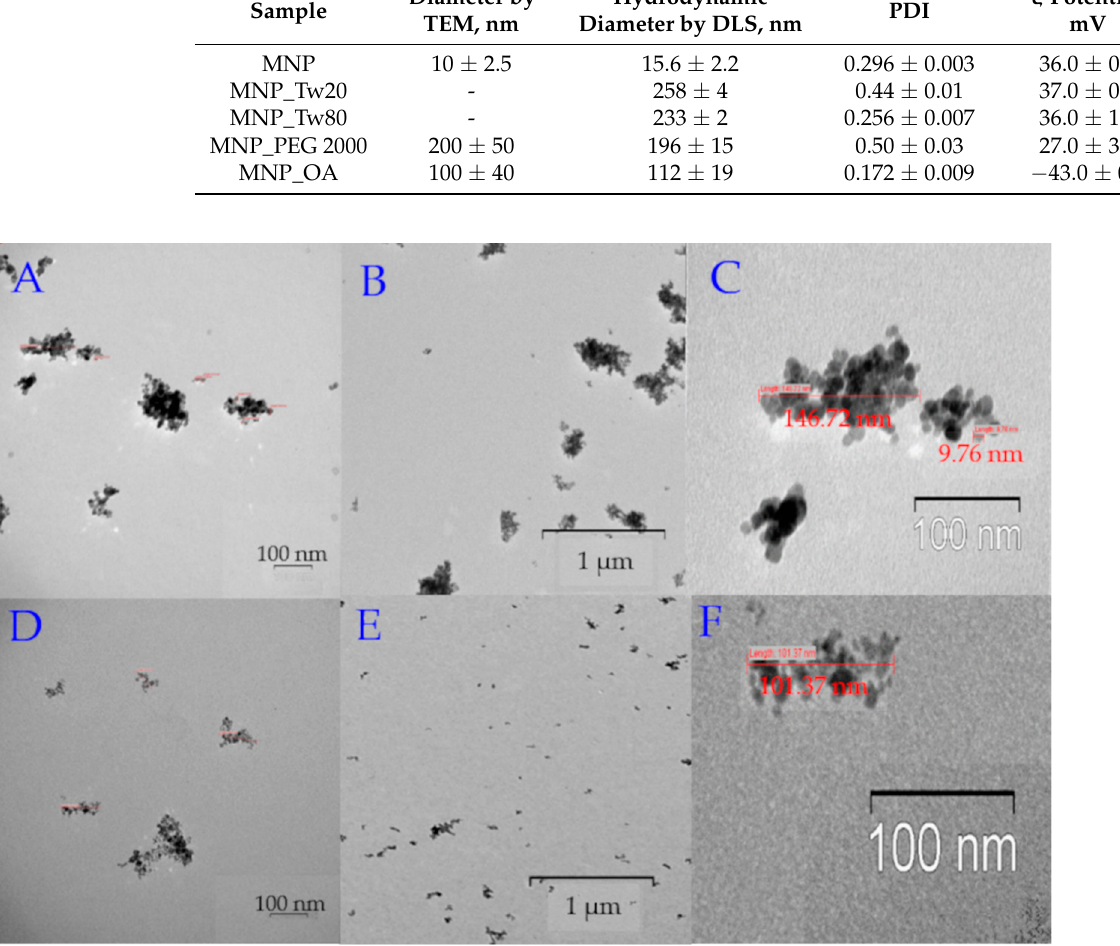
Figure 2. TEM images of MNPs. ( A ) High magnification TEM image MNP_PEG 2000; the bar indicates 100 nm. ( B ) Low magnification TEM image MNP_PEG 2000; the bar indicates 1 µ m. ( C ) TEM image reveals the MNP_PEG 2000 size (~150–200 nm). ( D ) High magnification TEM image MNP_OA; the bar indicates 100 nm. ( E ) Low magnification TEM image MNP_OA; the bar indicates 1 μ m. ( F ) TEM image reveals the MNP_OA size (~100–110 nm).